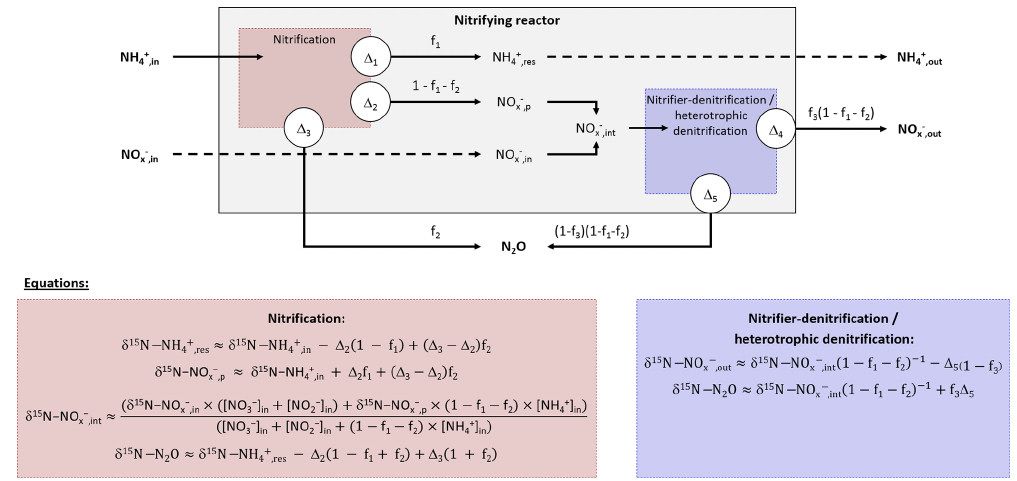
Figure 2. Diagram and equations of the nitrifying reactor after Fry (2006). It is considered as a sequence of two reactor boxes. (i) The ) and nitrous oxide (N 2 O) nitrification of inflow ammonium (NH + ) to a pool of nitrite and nitrate (NO − x , p ), residual ammonium (NH + 4 , in 4 , res through the hydroxylamine oxidation pathway. (ii) The subsequent reduction of intermediate NO − x , int : mixing of inflow NO − x , in and formed NO − x , p to nitrous oxide (N 2 O) through the nitrite reduction pathway, and residual NO − x that exits the reactor (NO − x , out ). Note that residual substrates and formed products exit the reactor without further isotope fractionation ( (cid:49) 1 and (cid:49) 4 are null). See text for